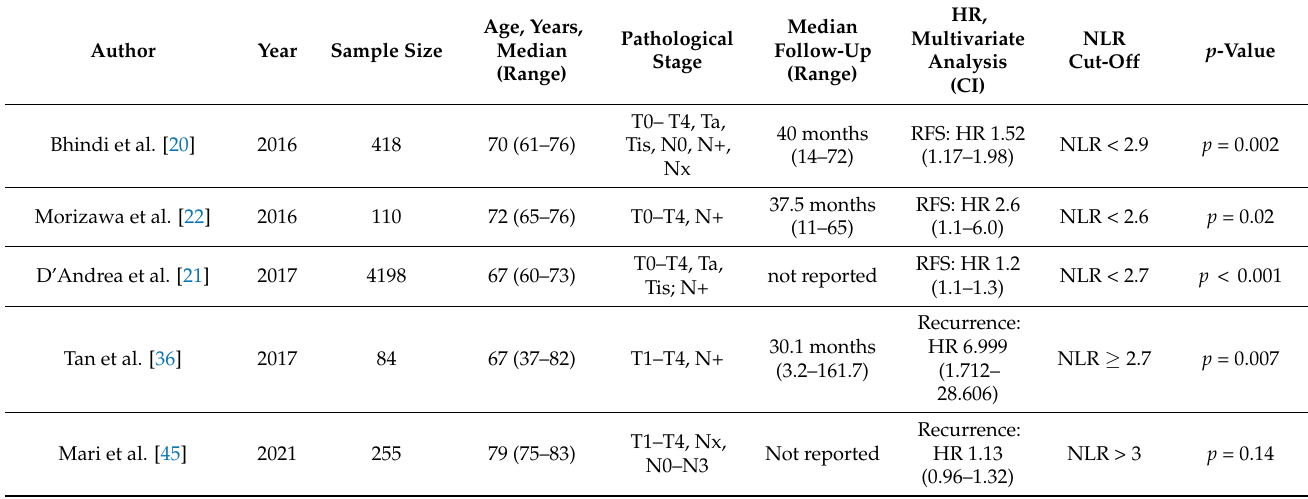
Table 2. Cont . Table 2. Eligible studies for the meta-analysis and their study characteristics.